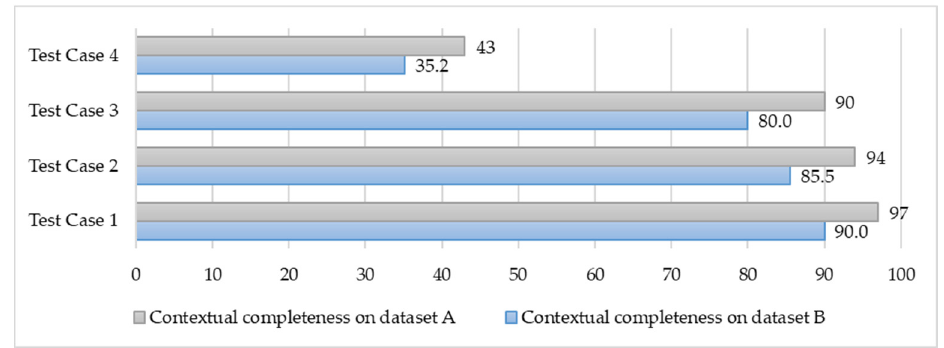
Figure 26. ASC application contextual data quality assessment with respect to completeness aspect.